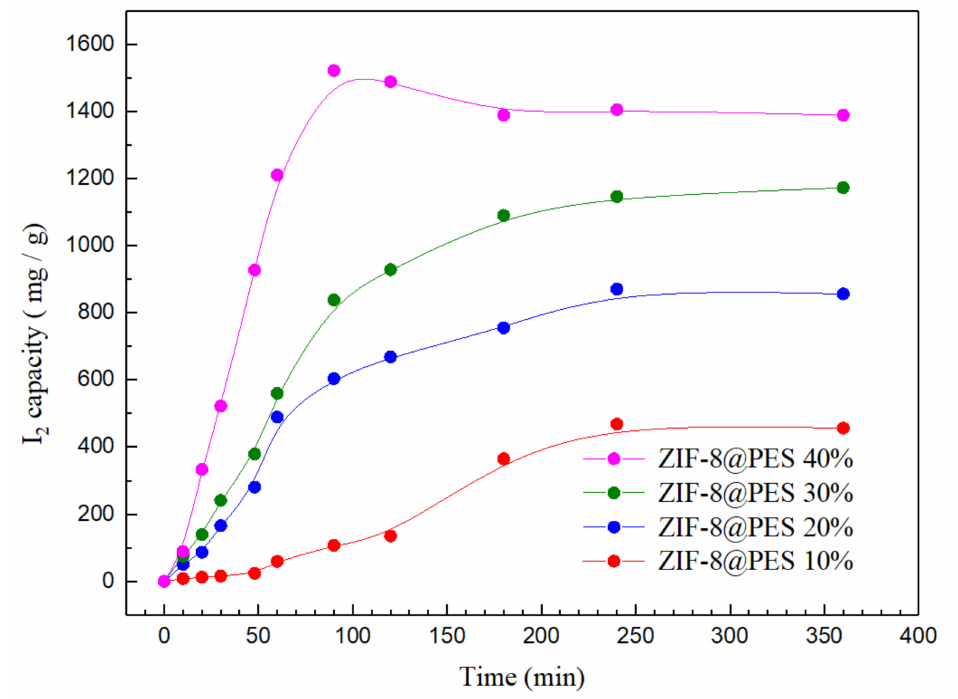
Figure 11. I 2 adsorption curve of prepared MMMs at di ff erent mixing ratios of ZIF-8.